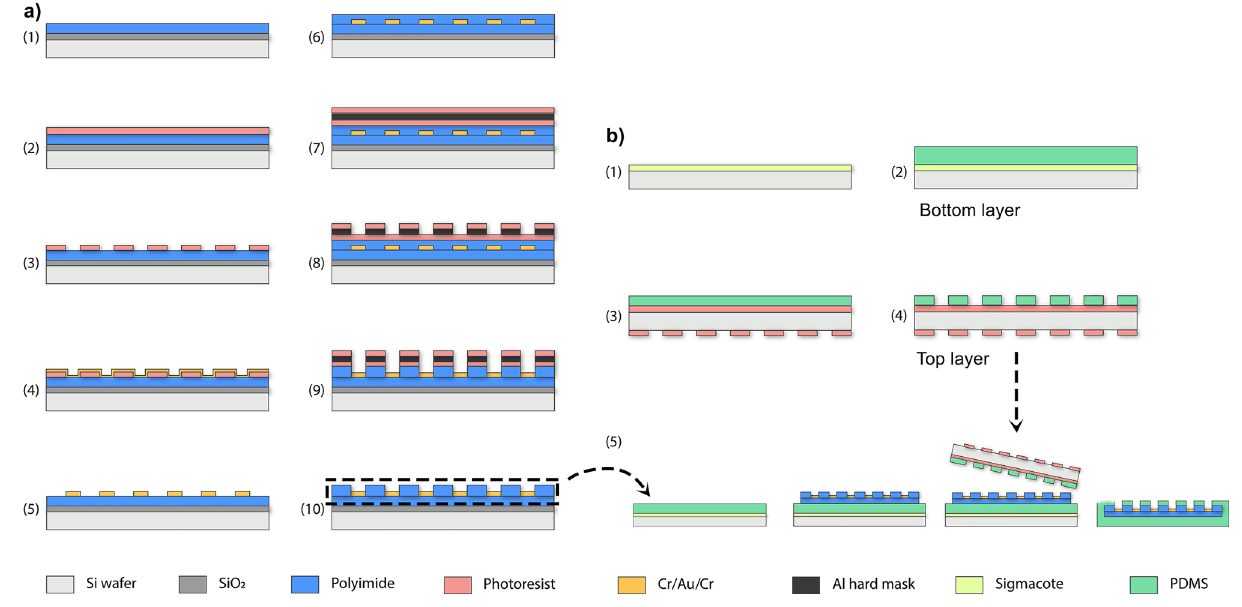
Figure 8. ( a ) Schematic illustration of sequential fabrication processes for polyimide-based electrode array. The bottom layer of polyimide was spin coated on the wafer and partially cured. Then, metal electrodes and conductive lines were patterned on polyimide by photolithography. Finally, the top of layer of polyimide was spin coated on top and patterned with electrode sites open. ( b ) Illustration of procedures to build sandwiched electrode array. Fabrication of the bottom layer and the top layer of PDMS with the guidance of back alignment marks. Then sandwich the polyimide-based electrode array between two layers of (Figure 8b (5)). Following the laser ablation to cut the outlines of the device, the sandwiched electrode array was peeled off from the bottom wafer.